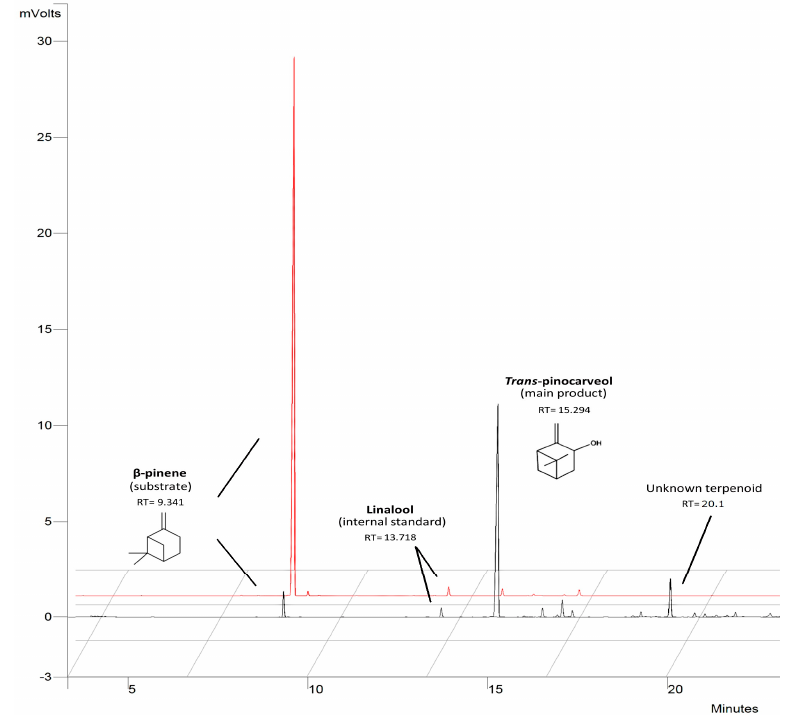
Figure 3. Gas Chromatography with Flame-Ionization Detection (GC-FID) chromatogram of main terpenoids obtained after 48 h of biotransformation of β -pinene by mutants of C. pannorum A-1. The initial substrate concentration was 1% ( v/v ). The red chromatogram refers to an abiotic control. For the twelve most active mutants, β -pinene biotransformation efficiency was associated with the survivability of conidia (in the range from 1.6 to 9.6%) after mutagenesis (Table 1). The highest biotransformation efficiencies were obtained by the mutants which showed 9.6% conidia survivability. An increase in the biotransformation of α -pinene to verbenol using Aspergillus niger and Penicillium spp. after treatment with UV irradiation, colchicine, or ethyl methanesulfonate (EMS) was reported by Agrawal et al. [45]. The best results were obtained when UV irradiation was used: the biotransformation efficiency increased 15- and 8-fold, respectively, reaching 58.5 mg/g d.w. × L (mg of the product per gram of dry weight of the mycelium per liter aqueous phase) for A. niger and 19.5 mg/g d.w. × L for Penicillium spp. By contrast, both strains produced substantially lower quantities of verbenone for all the treatments used, relative to the wild-type strain. In addition, compared to our study, those authors obtained much lower (5.4–16.2-fold) product concentrations [45].